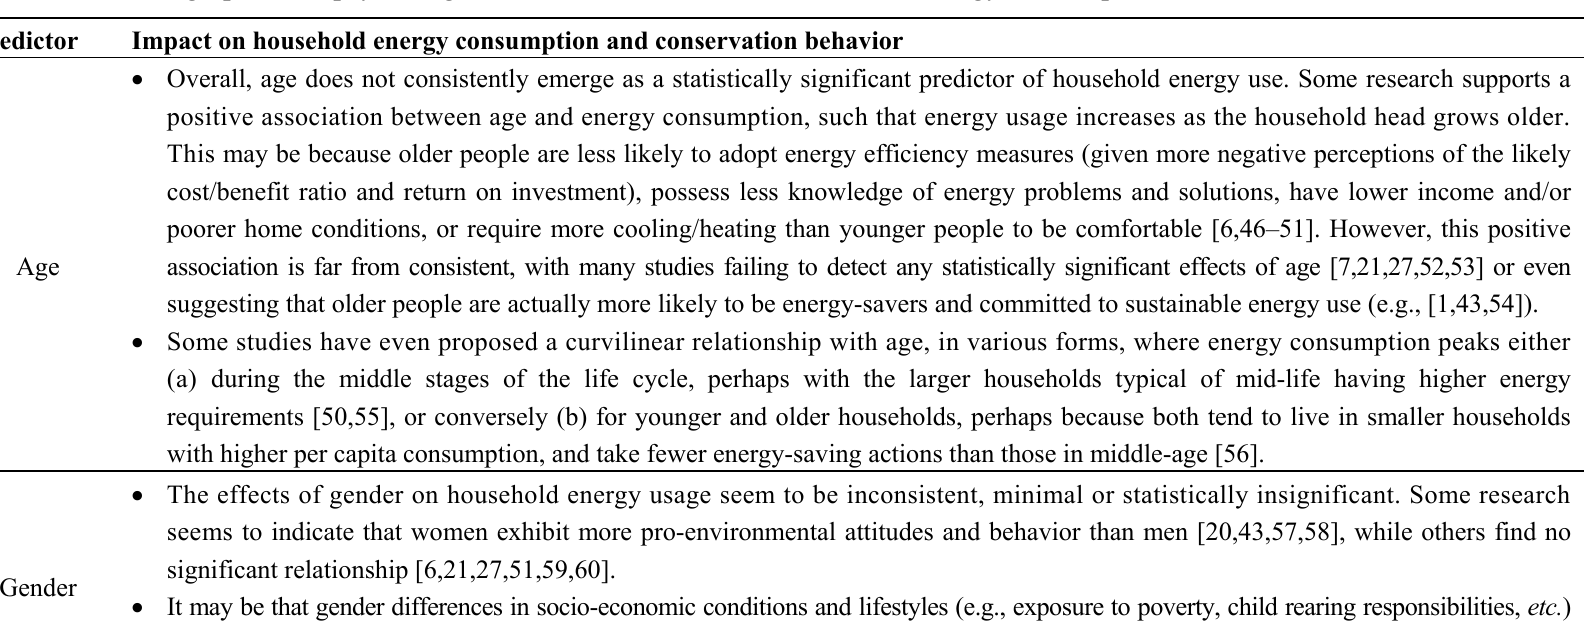
Table 1. Socio-demographic and psychological factors associated with household energy consumption and